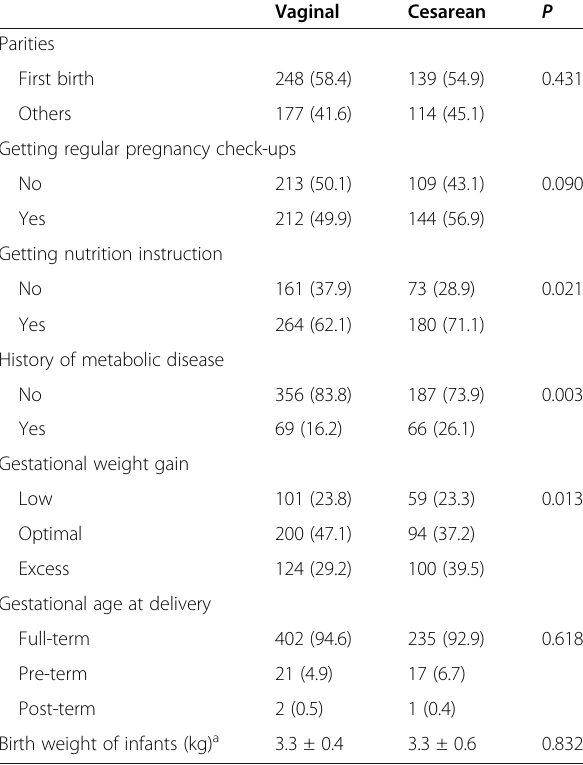
Table 2 Differences of health and pregnancy information between participants with different delivery modes Vaginal